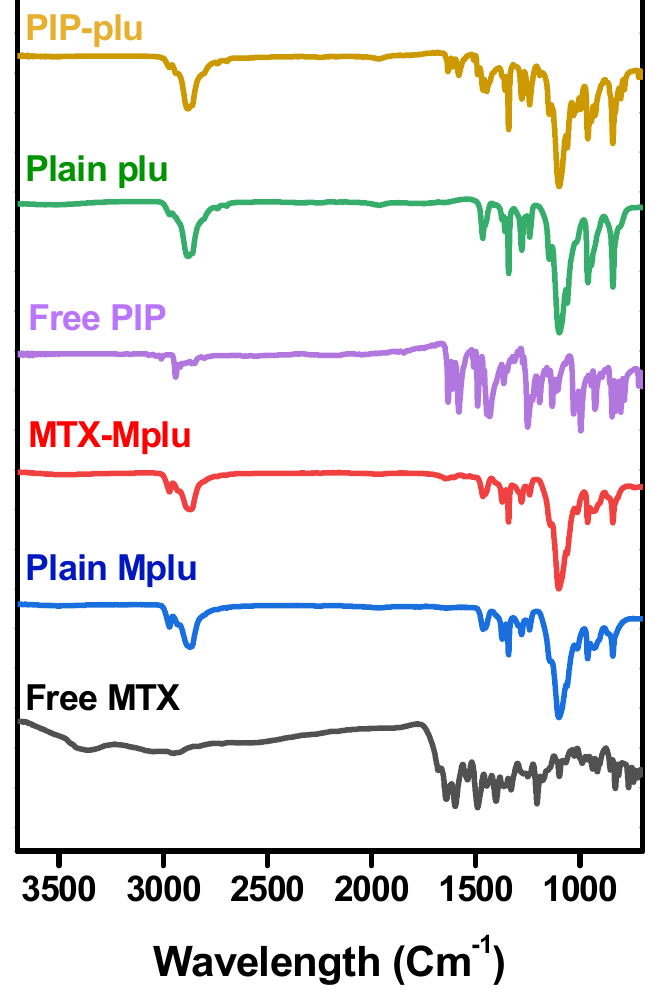
Figure 2. FTIR spectrum of free MTX, plain mixed pluronic nanomicelles (MNMs), MTX-MNMs free PIP, plain pluronic nanomicelles (NMs) and PIP-NMs.